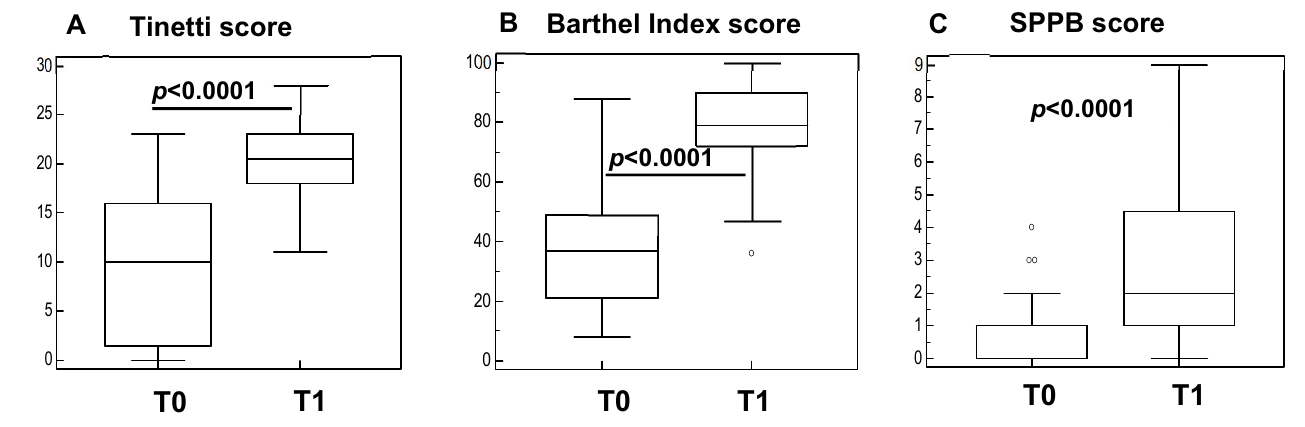
Figure 1. Clinical scores in sarcopenic subjects before (T0) and after rehabilitation (T1). Summary Figure 1. Tinetti ( A ), Barthel Index ( B ), and SPPB ( C ) clinical scores in sarcopenic subjects before. results are shown in the bar graphs. The boxes show the lower quartile, median (line across the (T0) and after rehabilitation (T1). Summary results are shown in the bar graphs. The boxes show boxes), and the upper quartile values. The whiskers represent the extreme values. The outside values the lower quartile, median (line across the boxes), and the upper quartile values. The whiskers are presented as separate points. Statistical significance is shown. represent the extreme values. The outside values are presented as separate points. Statistical significance is shown.